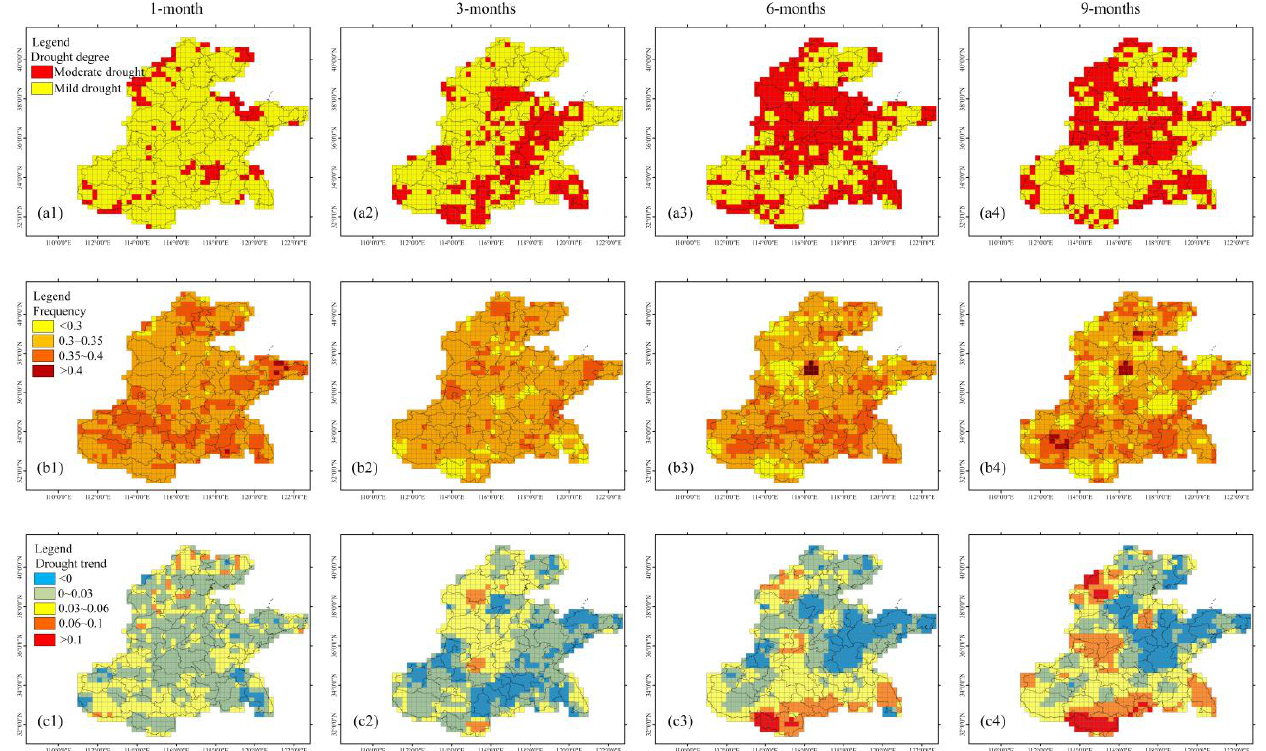
Figure 3. ( a1 – a4 ) Mean SPEI values. ( b1 – b4 ) Frequency of drought. ( c1 – c4 ) Spatial distribution trend of the SPEI during winter wheat growth in the NCP from 2001 to 2015 at 1, 3, 6, and 9 months,